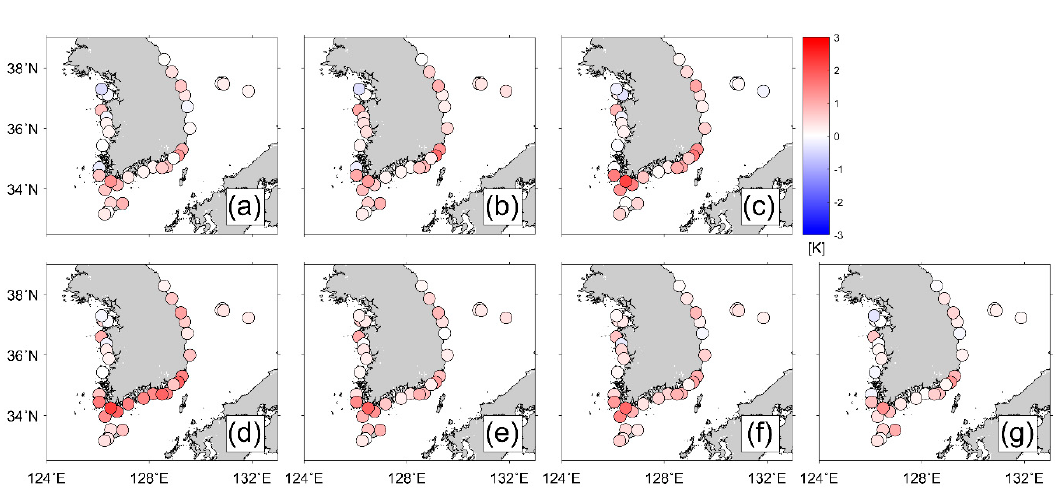
Figure 4. Spatial distribution of the bias errors of sea surface temperature (SST) analysis at the location of the coastal wave buoys—( a ) OSTIA; ( b ) CMC analysis; ( c ) OISST; ( d ) REMSS analysis; ( e ) MURSST; ( f ) MGDSST; and ( g ) Blended SST.